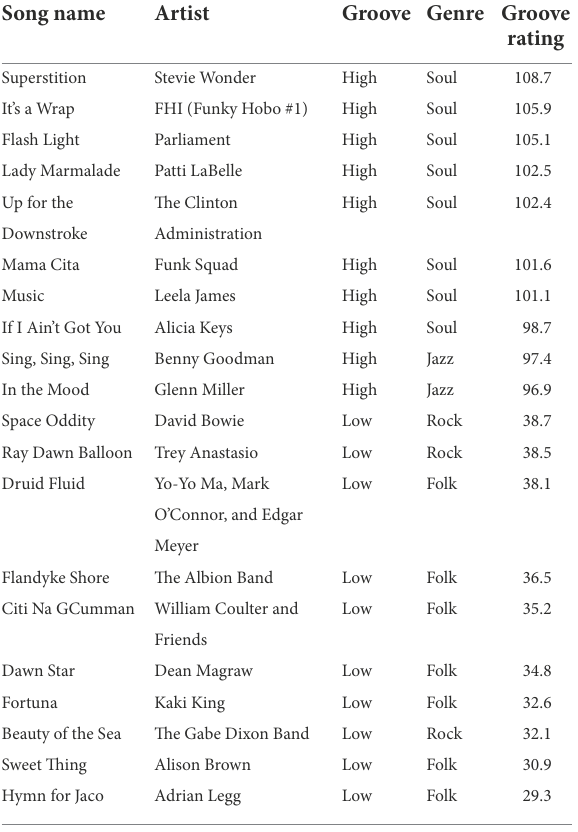
TABLE 3 Songs used in the musical groove judgment